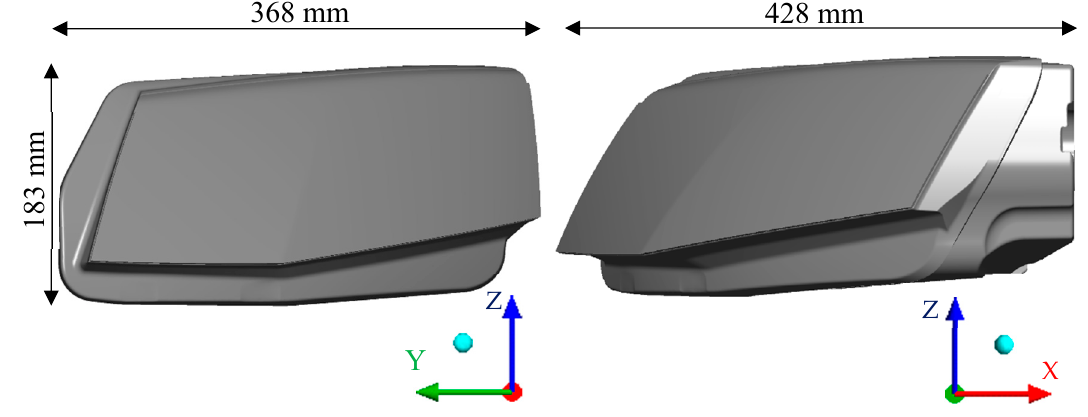
Figure 3. Main dimensions of the headlamp.